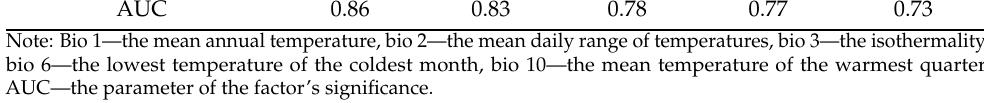
Bioclimatic Parameters